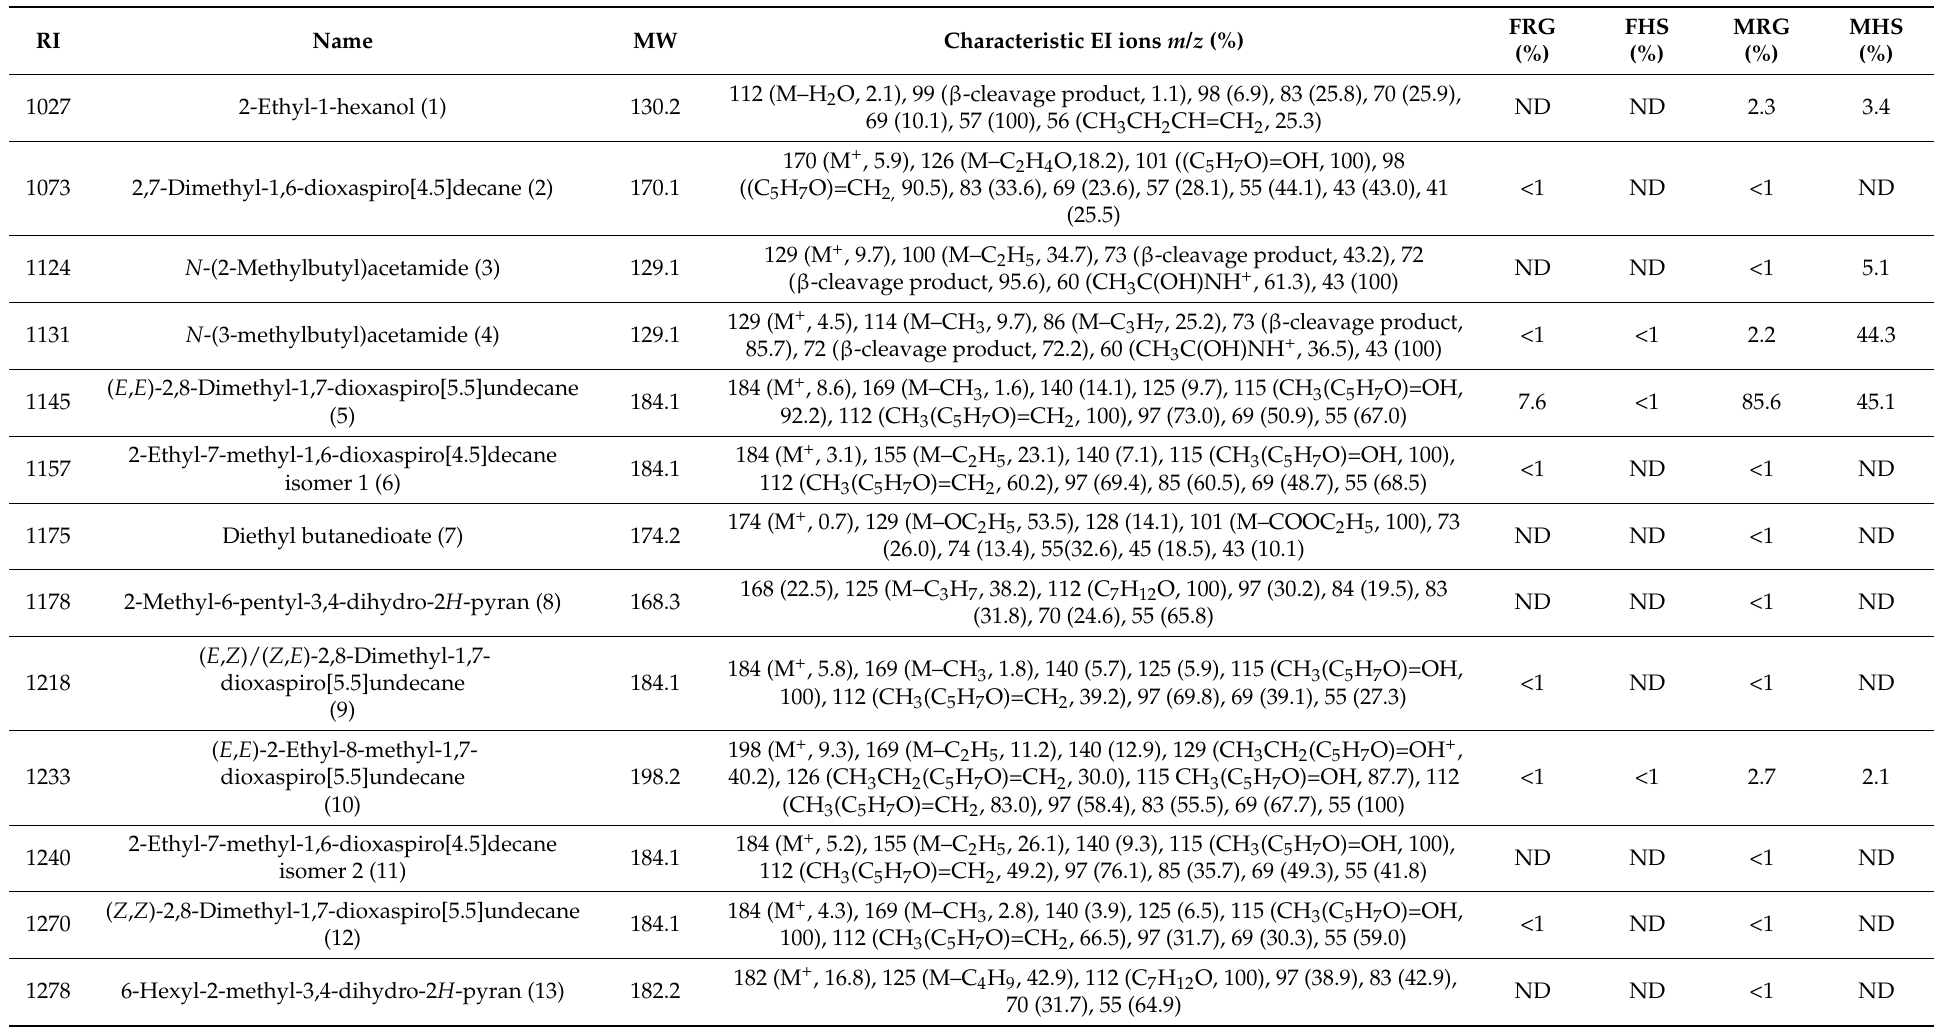
Table 1. Chemical profiles of B. kraussi adults. RI: retention index, MW: molecular weight, FRG: female rectal gland, FHS: female headspace, MRG: male rectal gland, MHS: male headspace, ND: not